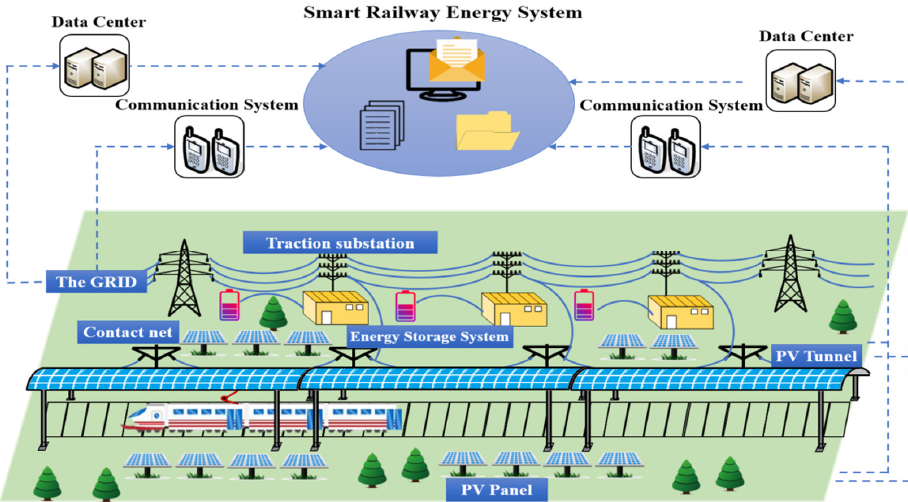
Figure 2. General architecture of photovoltaics (PV) energization method of China’s railway